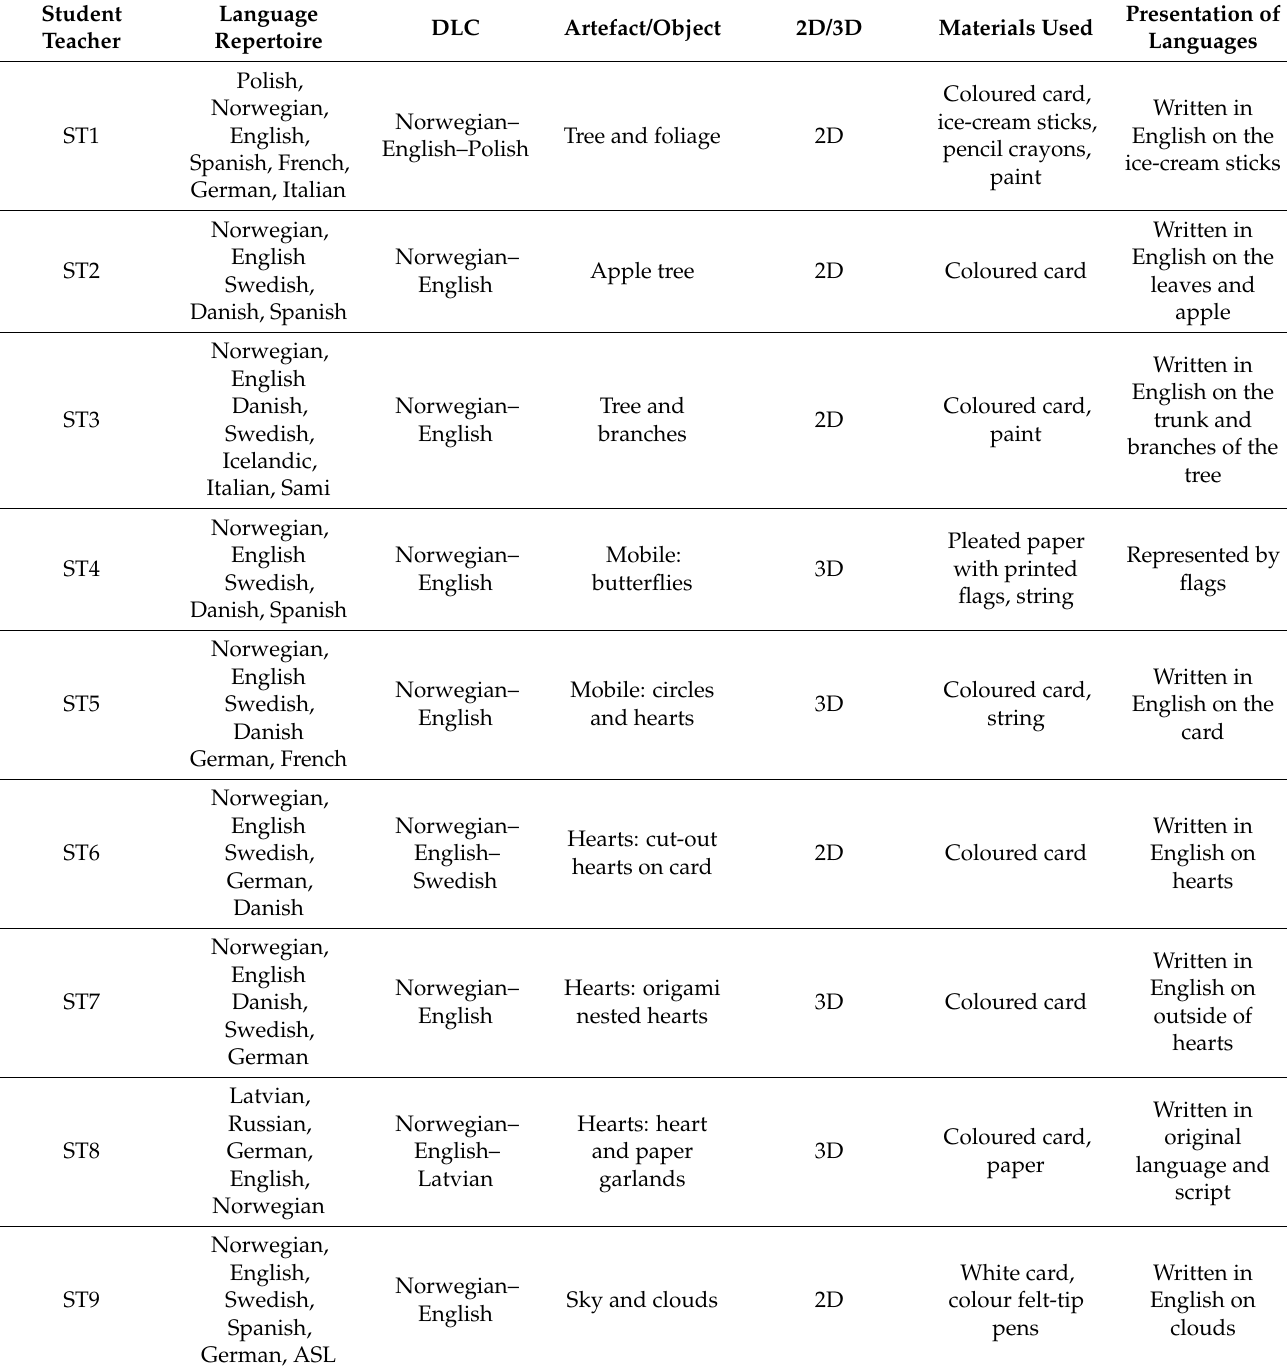
Table 1. Description of artefacts created by